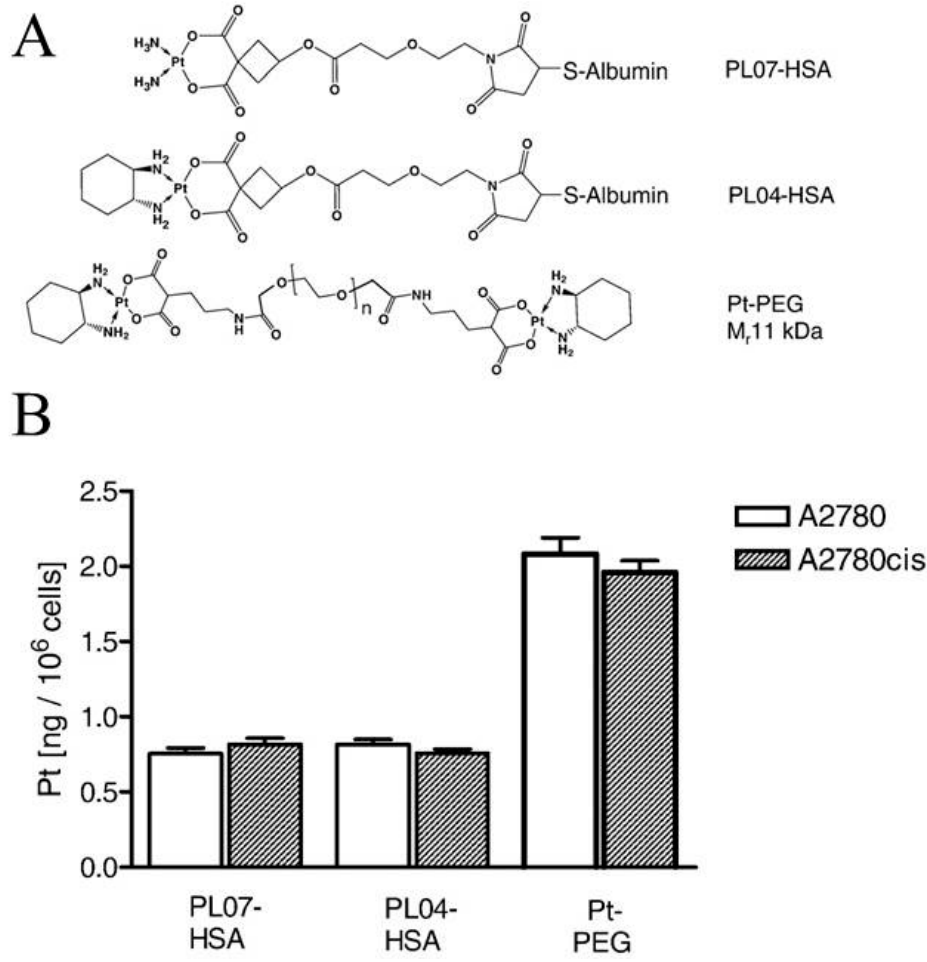
Figure 4. Accumulation of HAS and PEG conjugated Pt compounds in cisplatin-sensitive (A2780) and cisplatin-resistant (A2780cis) human ovarian cancer cells. ( A ) Structure of the Pt-albumin complexes PL07-HSA, PL04-HSA, and the Pt–polyethylene glycerol complex (PT-PEG); and ( B ) Platinum accumulation after 120 min exposure to PL07-HSA, PL04-HSA and PT-PEG. Reproduced with permission from [63].